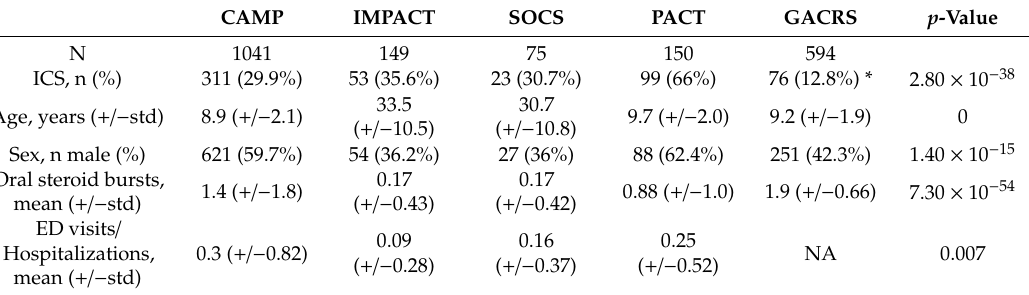
Table 3. Population